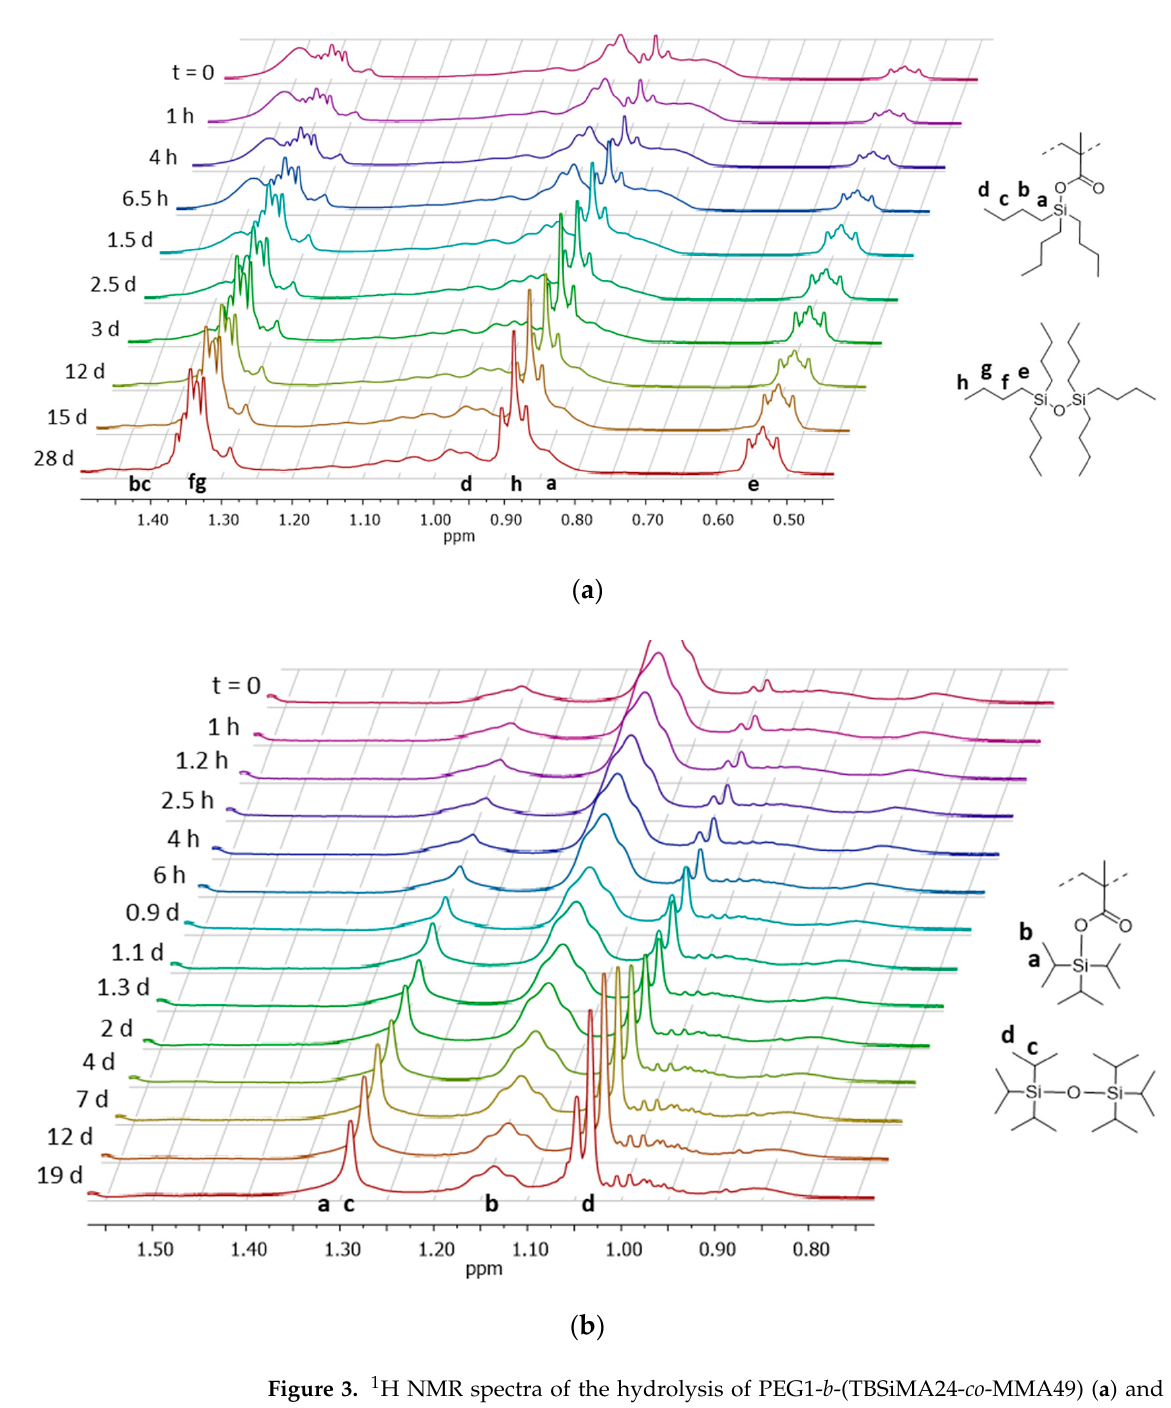
Figure 3. 1H NMR spectra of the hydrolysis of PEG1- b -(TBSiMA24- co -MMA49) ( a ) and PEG2- b -(TPSiMA28- co -MMA38) ( b ) in solution of THF-d8 with pH 10 buffer at different sampling times (increasing from back to front, from t = 0 to t = 19 or 28 days, respectively).